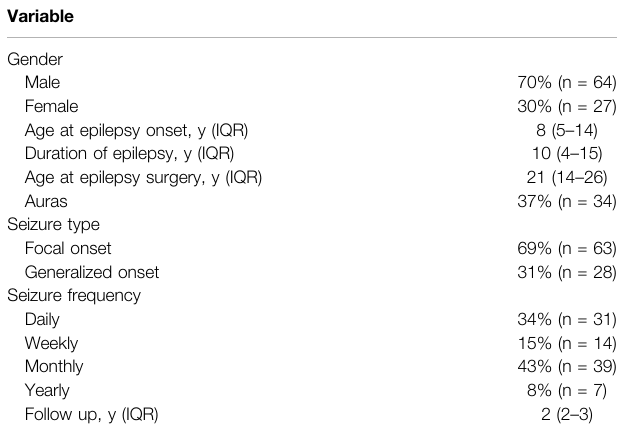
TABLE 1 | Demographics and Clinical Data of participants. Variable Gender